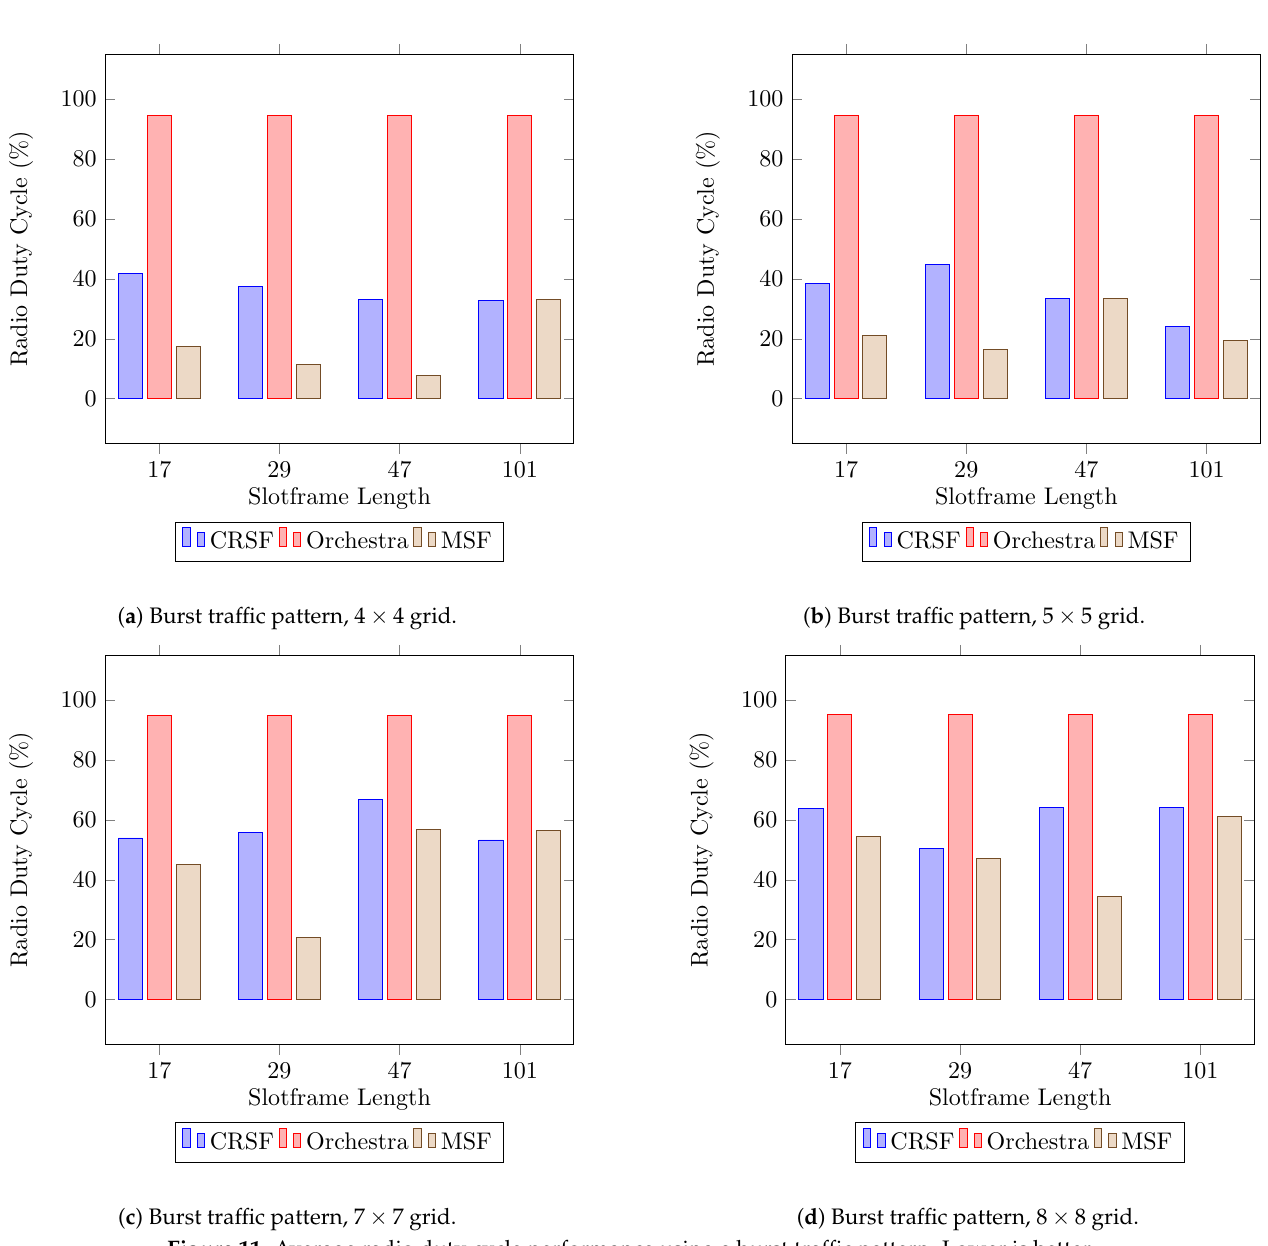
( c ) Burst traffic pattern, 7 × 7 grid. ( d ) Burst traffic pattern, 8 × 8 grid. Figure 11. Average radio duty cycle performance using a burst traffic pattern. Lower is